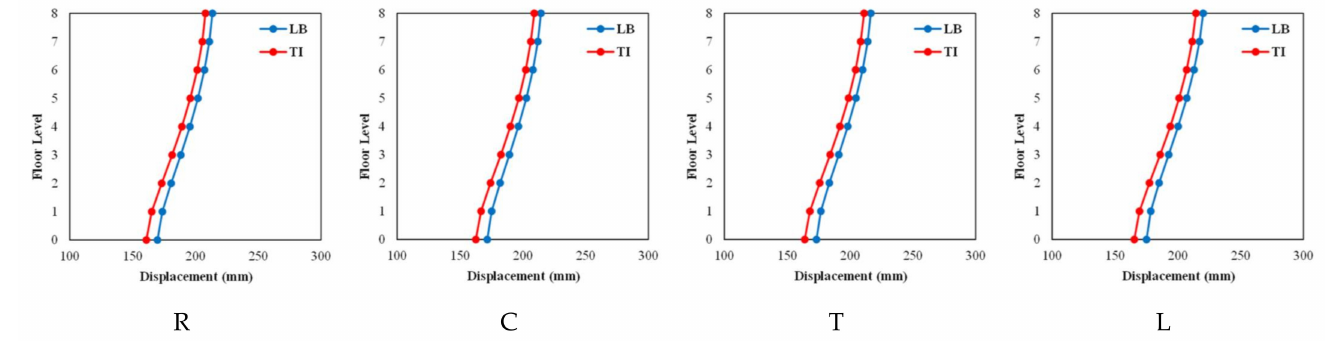
Figure 10. Floor displacements for R, C, T, and L